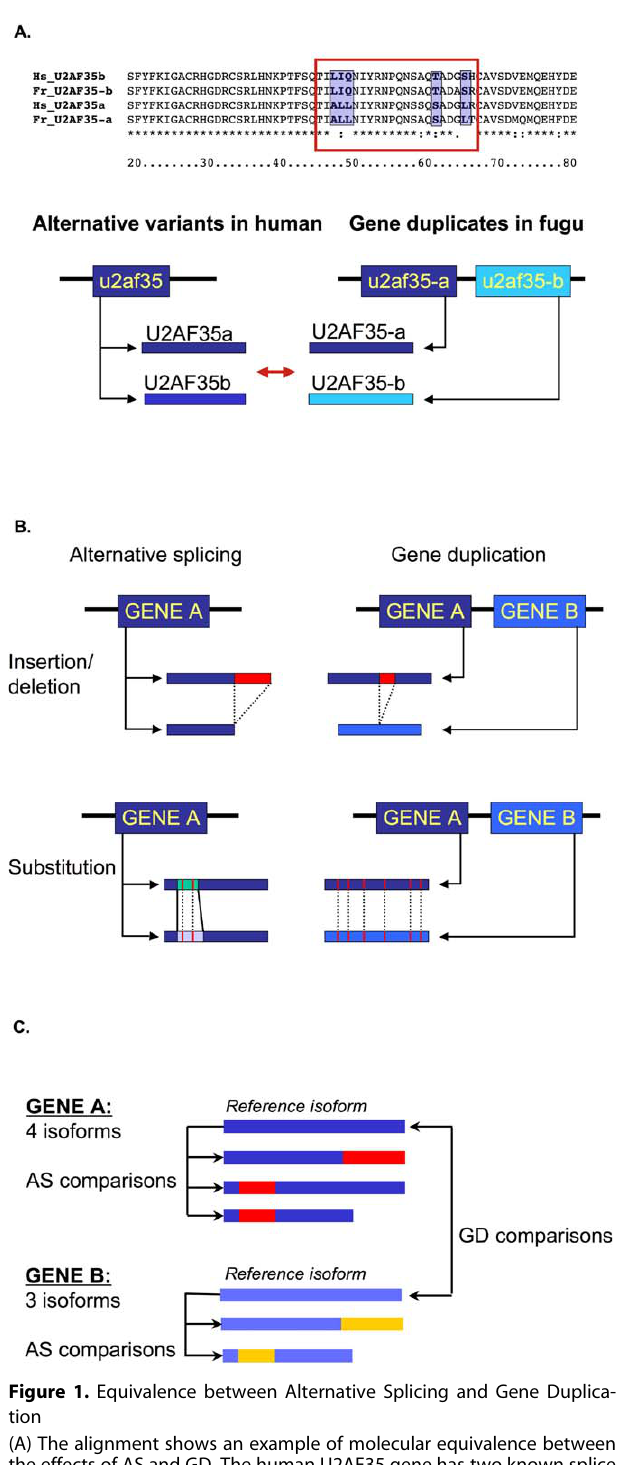
Figure 1. Equivalence between Alternative Splicing and Gene Duplica- tion (A) The alignment shows an example of molecular equivalence between the effects of AS and GD. The human U2AF35 gene has two known splice variants, Hs_U2AF35a and Hs_U2AF35b, that differ along the region marked with a red box. The fugu orthologue Fr_U2AF35-a does not have known splice variants, but instead has a paralogue, Fr_U2AF35-b [9]. All sequences have kindly been provided by T. R. Pacheco and M. Carmo- Fonseca. For some residues (bold, highlighted in light blue), the substitutions amongst the human splice variants are equivalent to those in the fugu GD. The cartoon illustrates the relationship between the human and fugu sequences. The names of genes and their protein products are denoted in small and capital letters, respectively. At the molecular level, AS and GD show equivalent changes to sequence, and therefore are likely to have interchangeable effects on structure